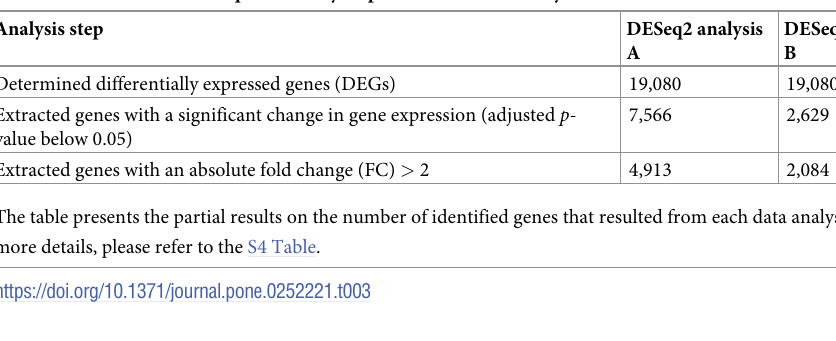
Table 3. Results of the DESeq2 data analyses performed in this